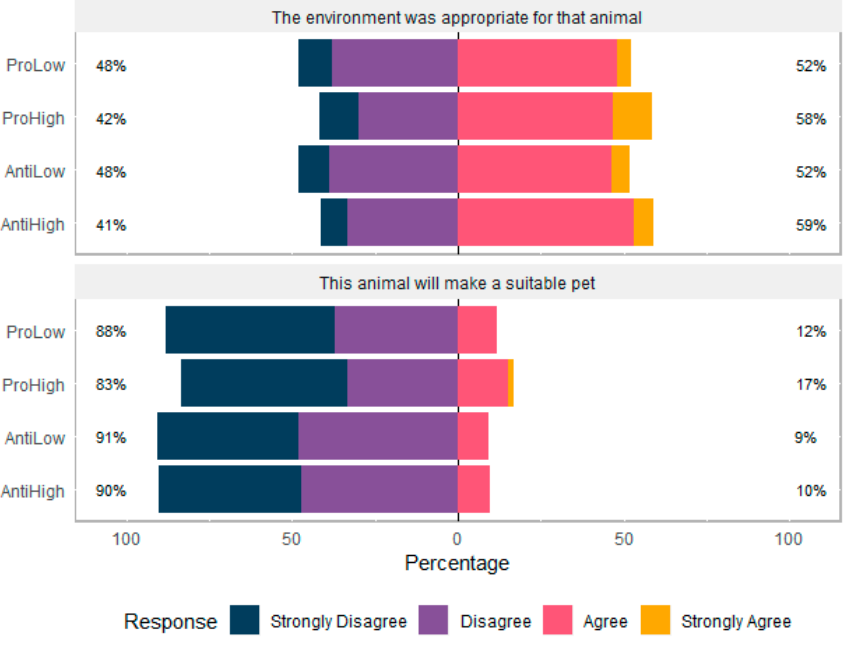
Figure 2. Participants agreement rating regarding environment and pet suitability of primate across social media site (SMS) condition (N = 211).